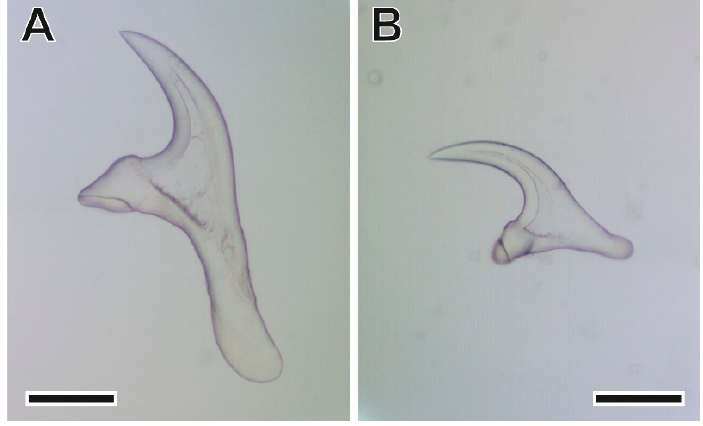
Figure 4. Large ( A ) and small ( B ) hooks of Hydatigera taeniaeformis larvae. Scale bar = 200 µm.